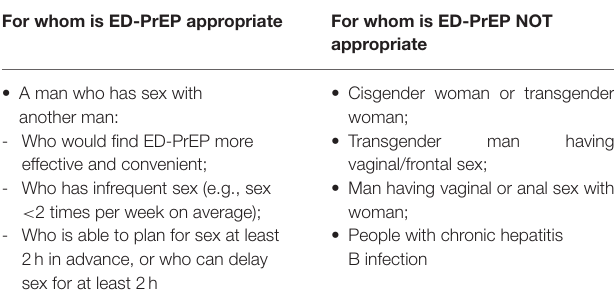
TABLE 3 | Situations when event-driven (ED) PrEP could be